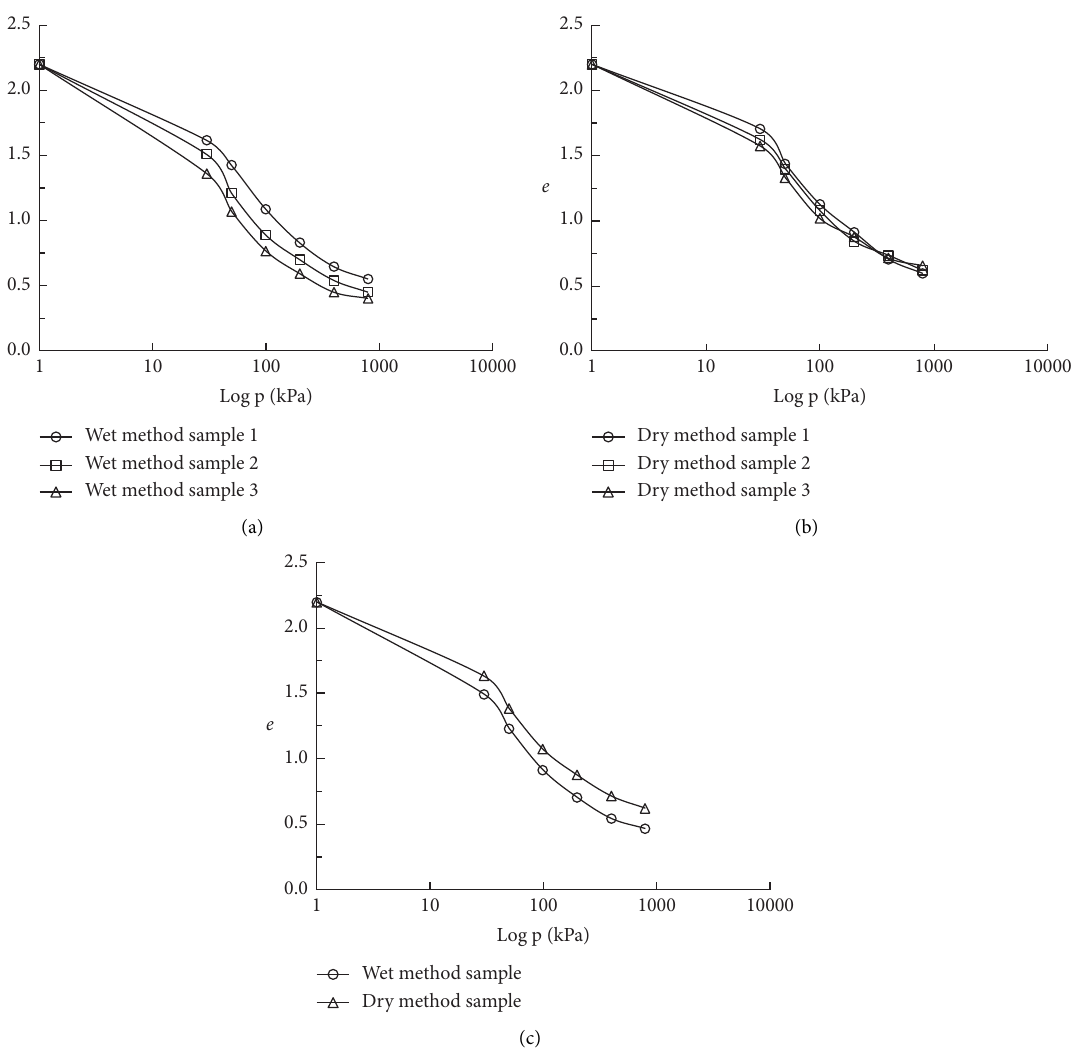
Figure 7: Biodegradation compression curves of different samples. (a) Wet method samples. (b) Dry method samples. (c) Average curves comparison. Table 10: Variance of void ratio of different sample types in compression tests ( × 10 − 3 ). Vertical stress